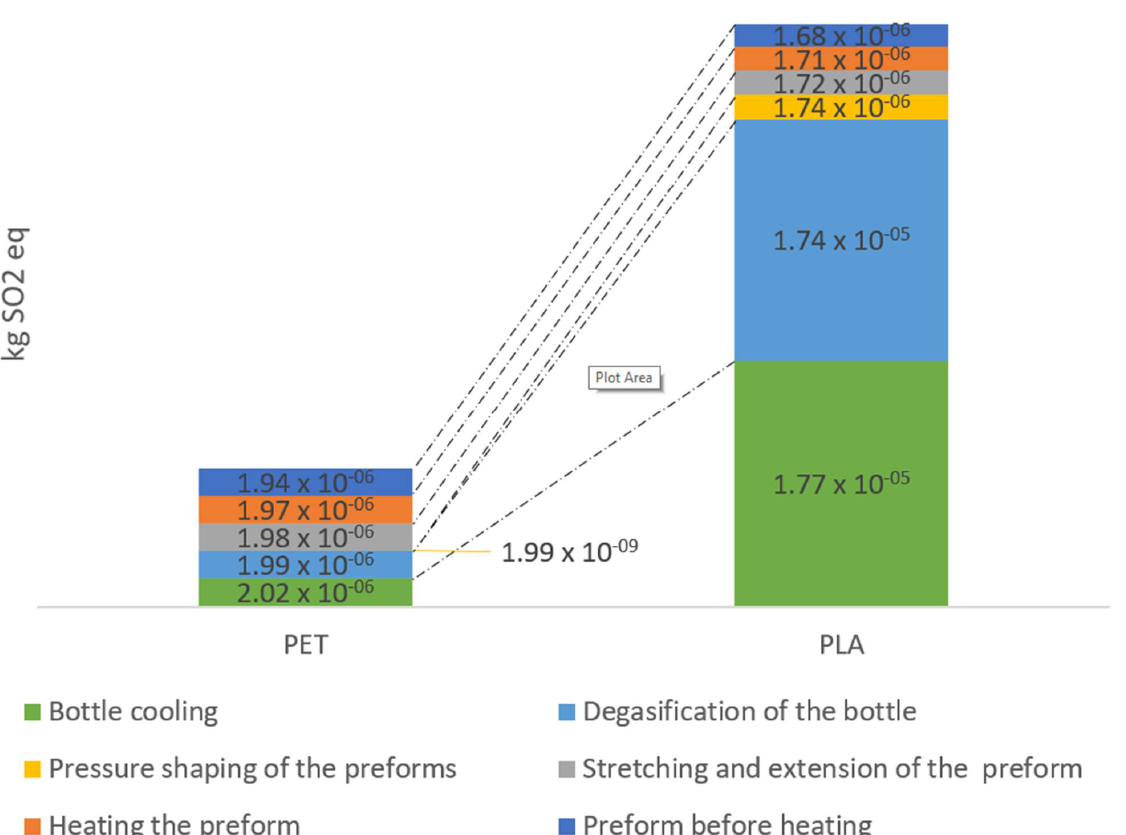
Figure 4. Acidification emissions throughout the entire bottle shaping process. Analyzing the category of eutrophication for each technological operation, similar values of environmental influences were observed throughout the whole life cycle (Figure 5). The lowest calcium phosphorus emission value for the preform conveyor PLA process was 0.208 kg PO 4 /1000 bottles and 0.212 kg PO 4 /1000 bottles of PET. Higher levels of calcium phosphorus emissions were recorded for PLA bottle shaping operations, i.e., stretching and lengthening the preform 0.245 kg PO 4 /1000 bottles, blowing preforms 0.259 kg PO 4 /1000 bottles, degassing the bottle 0.261 kg PO 4/ 1000 bottles, and cooling the bottle with compressed air 0.265 kg PO 4 /1000 bottles.